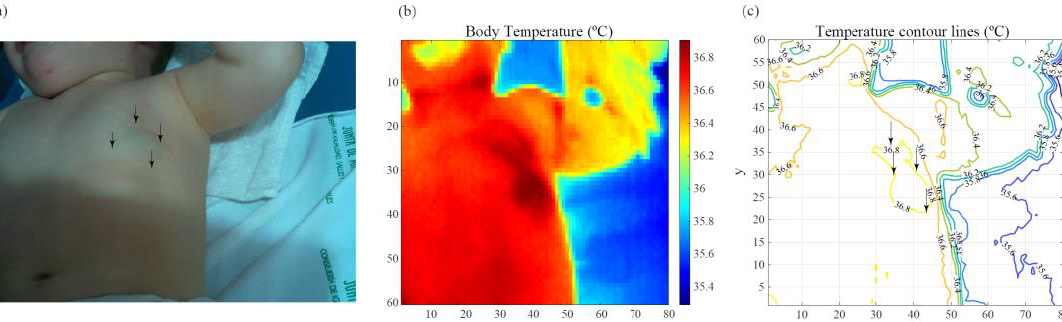
Figure 7. Illustration of the applicability of the area estimation method for a deep focal IH. Area calculation is challenging by visual inspection. Thermography facilitates the process. ( a ) Visible image. ( b ) Thermographic image. ( c ) Detail of the temperature contour lines. The arrows indicate the region affected by the IH.